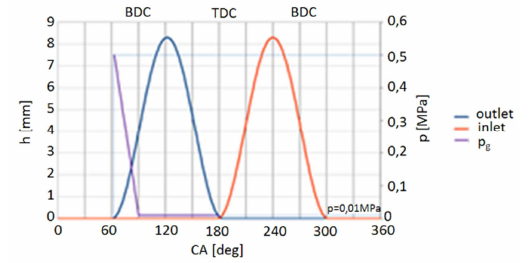
Fig. 2. The graph of valve lifts and modelled pressure p g in the cylinder as a function of camshaft rotation for the tested